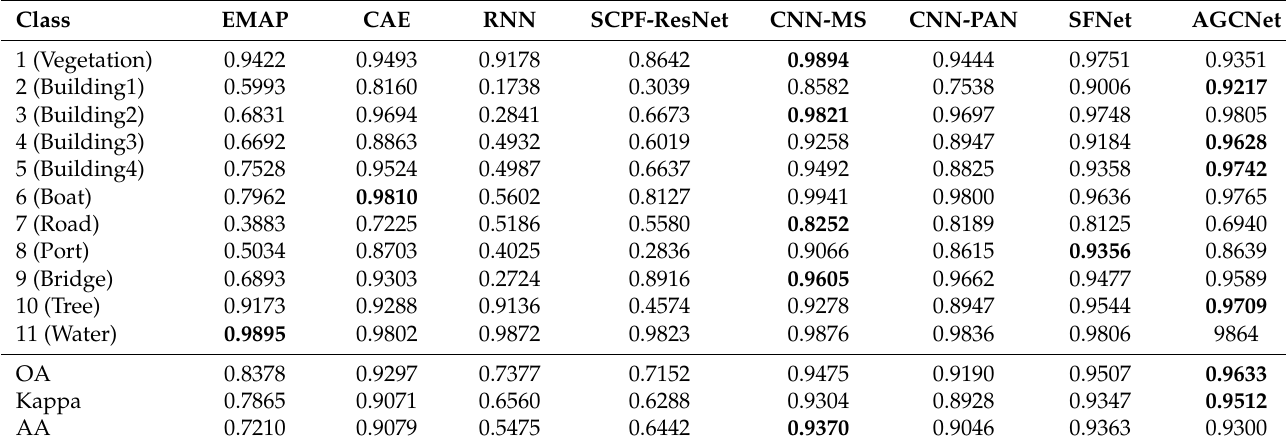
Table 2. Classification accuracy on Level 1B dataset.